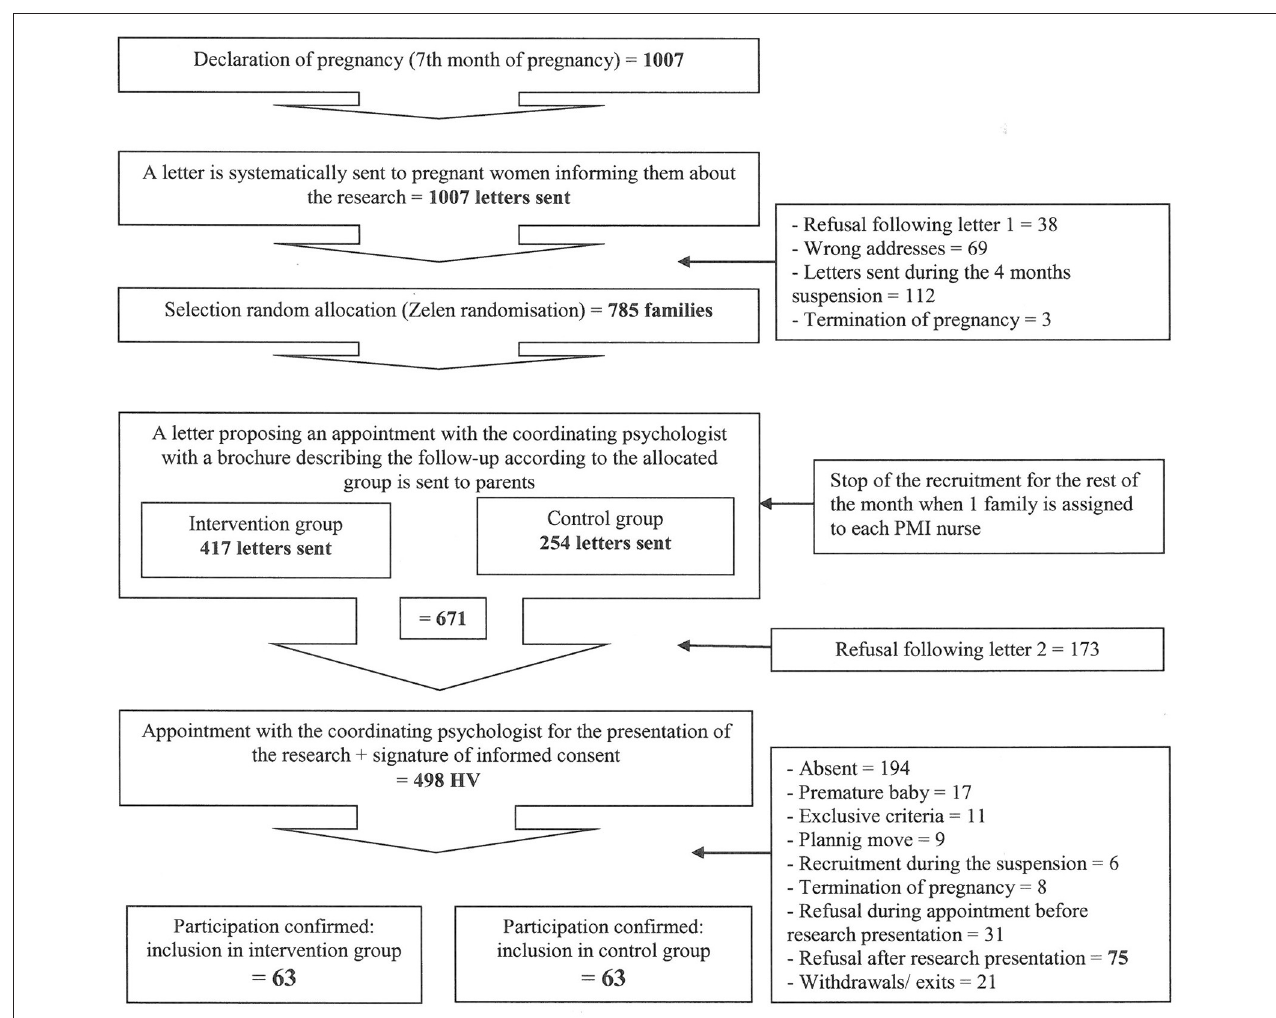
FIGURE 1 | Recruiting method of the PERL